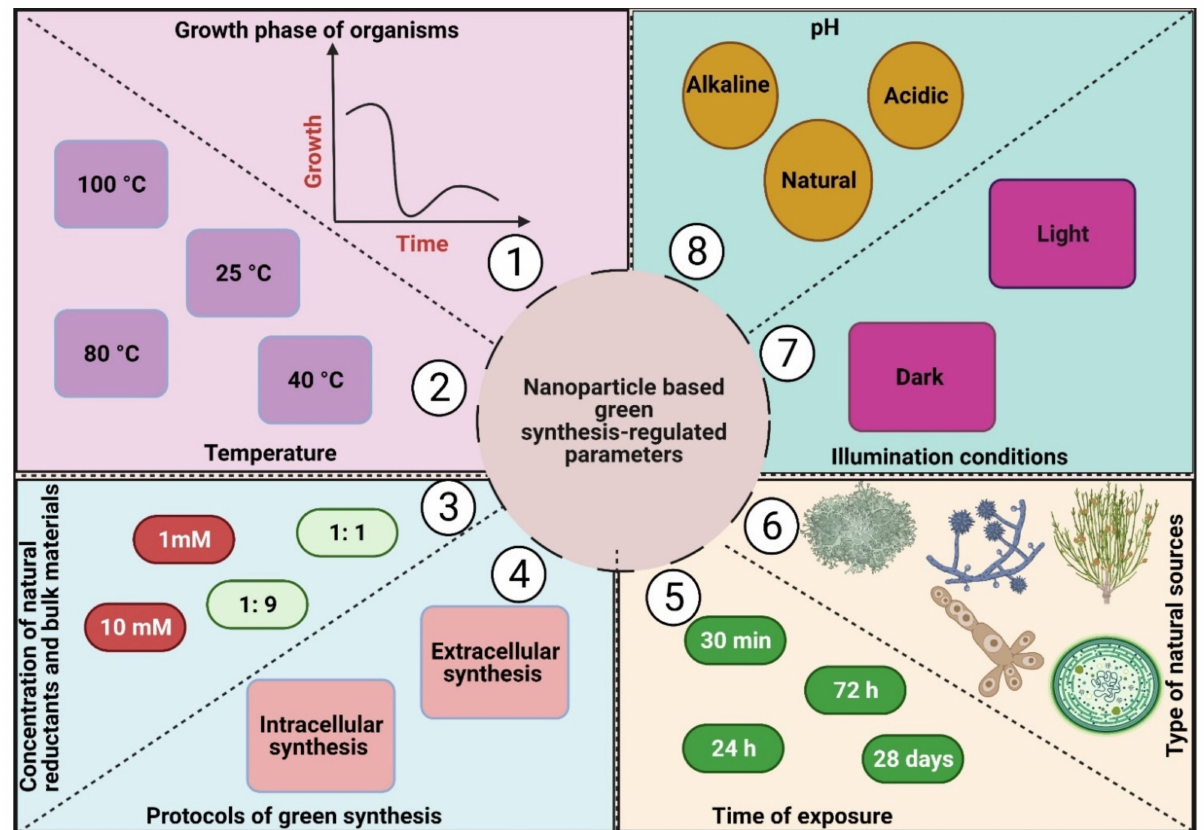
Figure 6. Nanoparticle-based, green synthesis-regulated parameters including ( 1 ) growth phase of organisms, ( 2 ) tempera- ture, ( 3 ) concentrations of reductants and bulk materials, ( 4 ) protocols of green synthesis, ( 5 ) time of exposure, ( 6 ) type of natural sources, ( 7 ) illumination conditions and ( 8 )